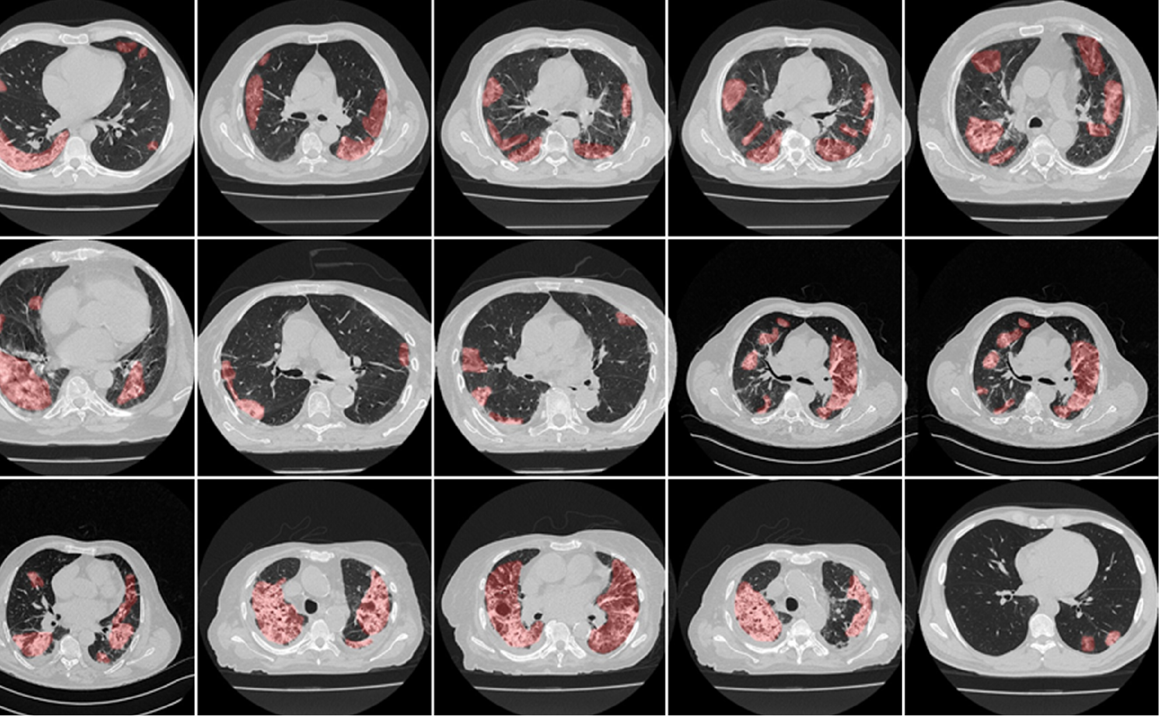
Figure 3. Manual delineation overlays (red) from tracer 1 on raw CT images.